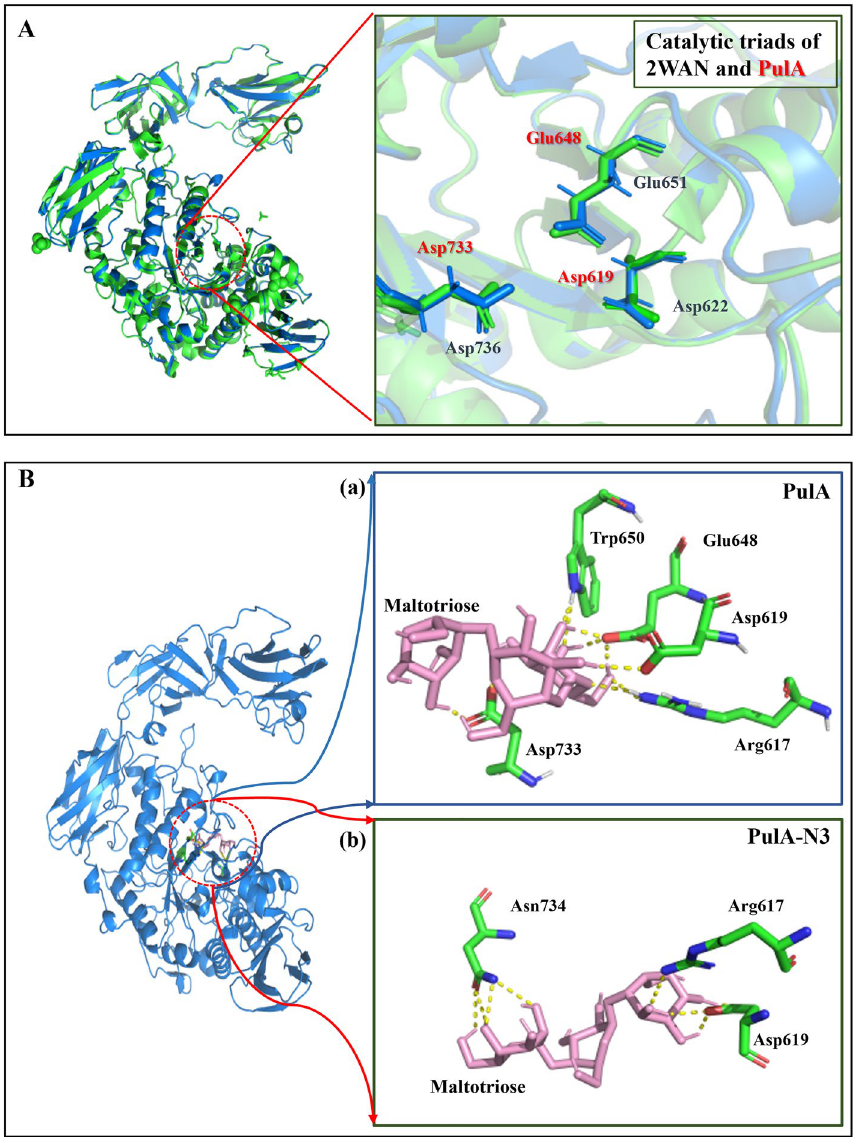
Figure 2. Structural schematic diagram of pullulanase. ( A ) Structural superposition of the predicted catalytic triads of PulA; B: the schematic diagram of PulA ( a ) and PulA-N3 ( b ) binding maltotriose. Pullulanase 2WAN (PDB ID: 2WAN) was used as template for homology modeling using software SWISS-MODEL Protein- modeling Server. Structure comparison and analysis of the wild-type enzyme and the mutants were performed by the program of PyMOL. Maltotriose was used as ligand for molecular docking by using Auto Dock software. The protein structure derived from the above homology modeling was used as the receptor structure. The number presented in the diagram represented the binding free energy.